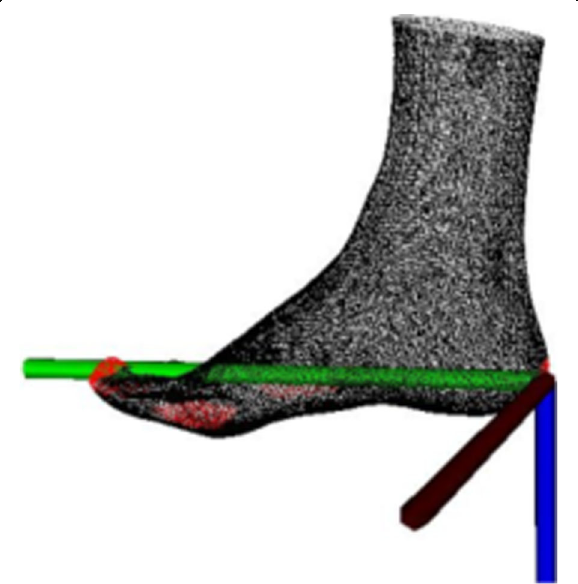
Fig. 5 Foot ’ s depth image after coordinate